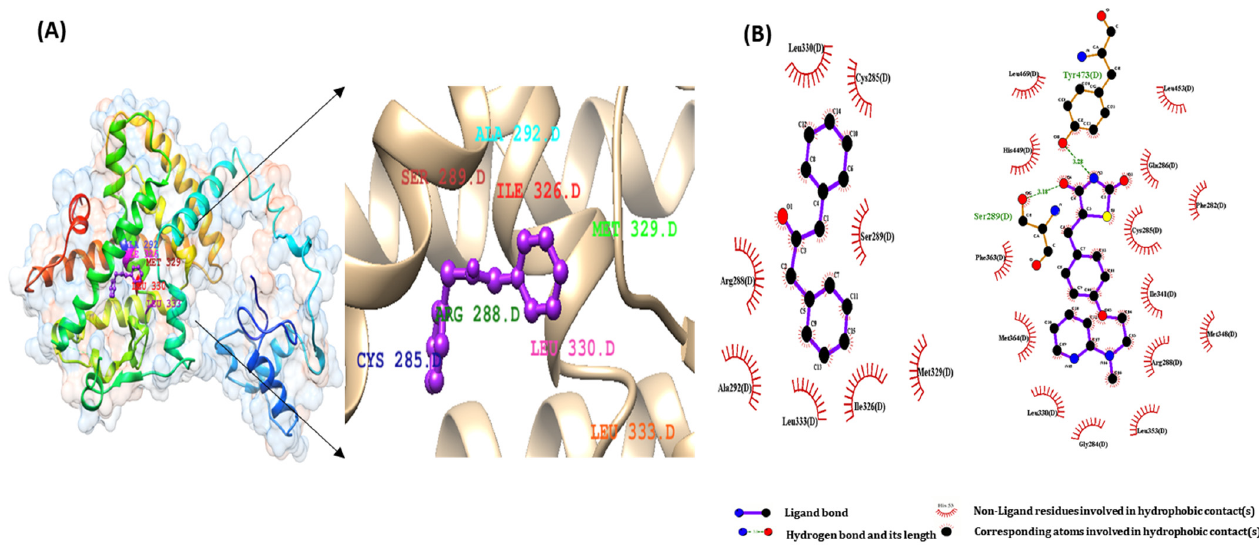
Figure 5. ( A )The binding interactions of 1,3–Diphenyl-2-propanone ligand with PPAR γ protein ( B ) pharmacophore analysis between PPAR γ and active components of 1,3-Diphenyl-2-propanone and PPAR γ -rosiglitazone (control).